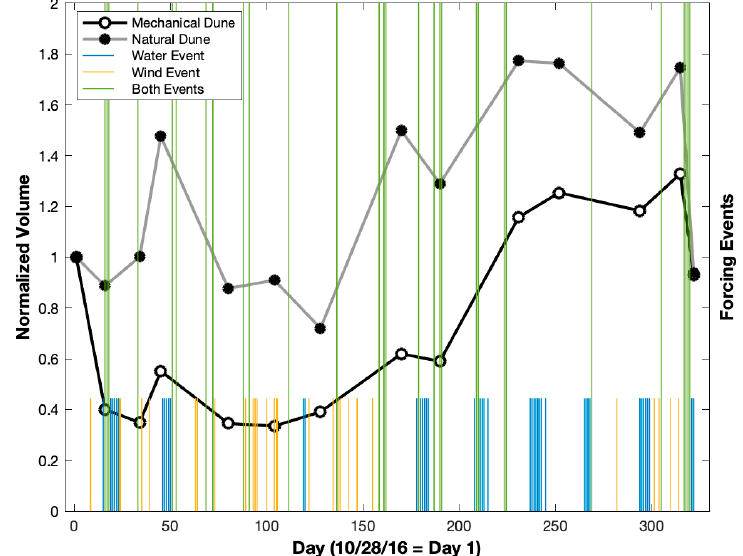
Figure 8. Images of the natural ( a, b, d ) and mechanical dune ( a, d, e ) on 03/25 ( a ), 04/15 ( b ) and ( c ), and 05/05 ( d ) and ( e ). In ( a ) the natural (left) and mechanical (right) dunes are delineated by the orange dotted line. Colored arrows point to the same locations and are coordinated to the arrows in Figure 3.